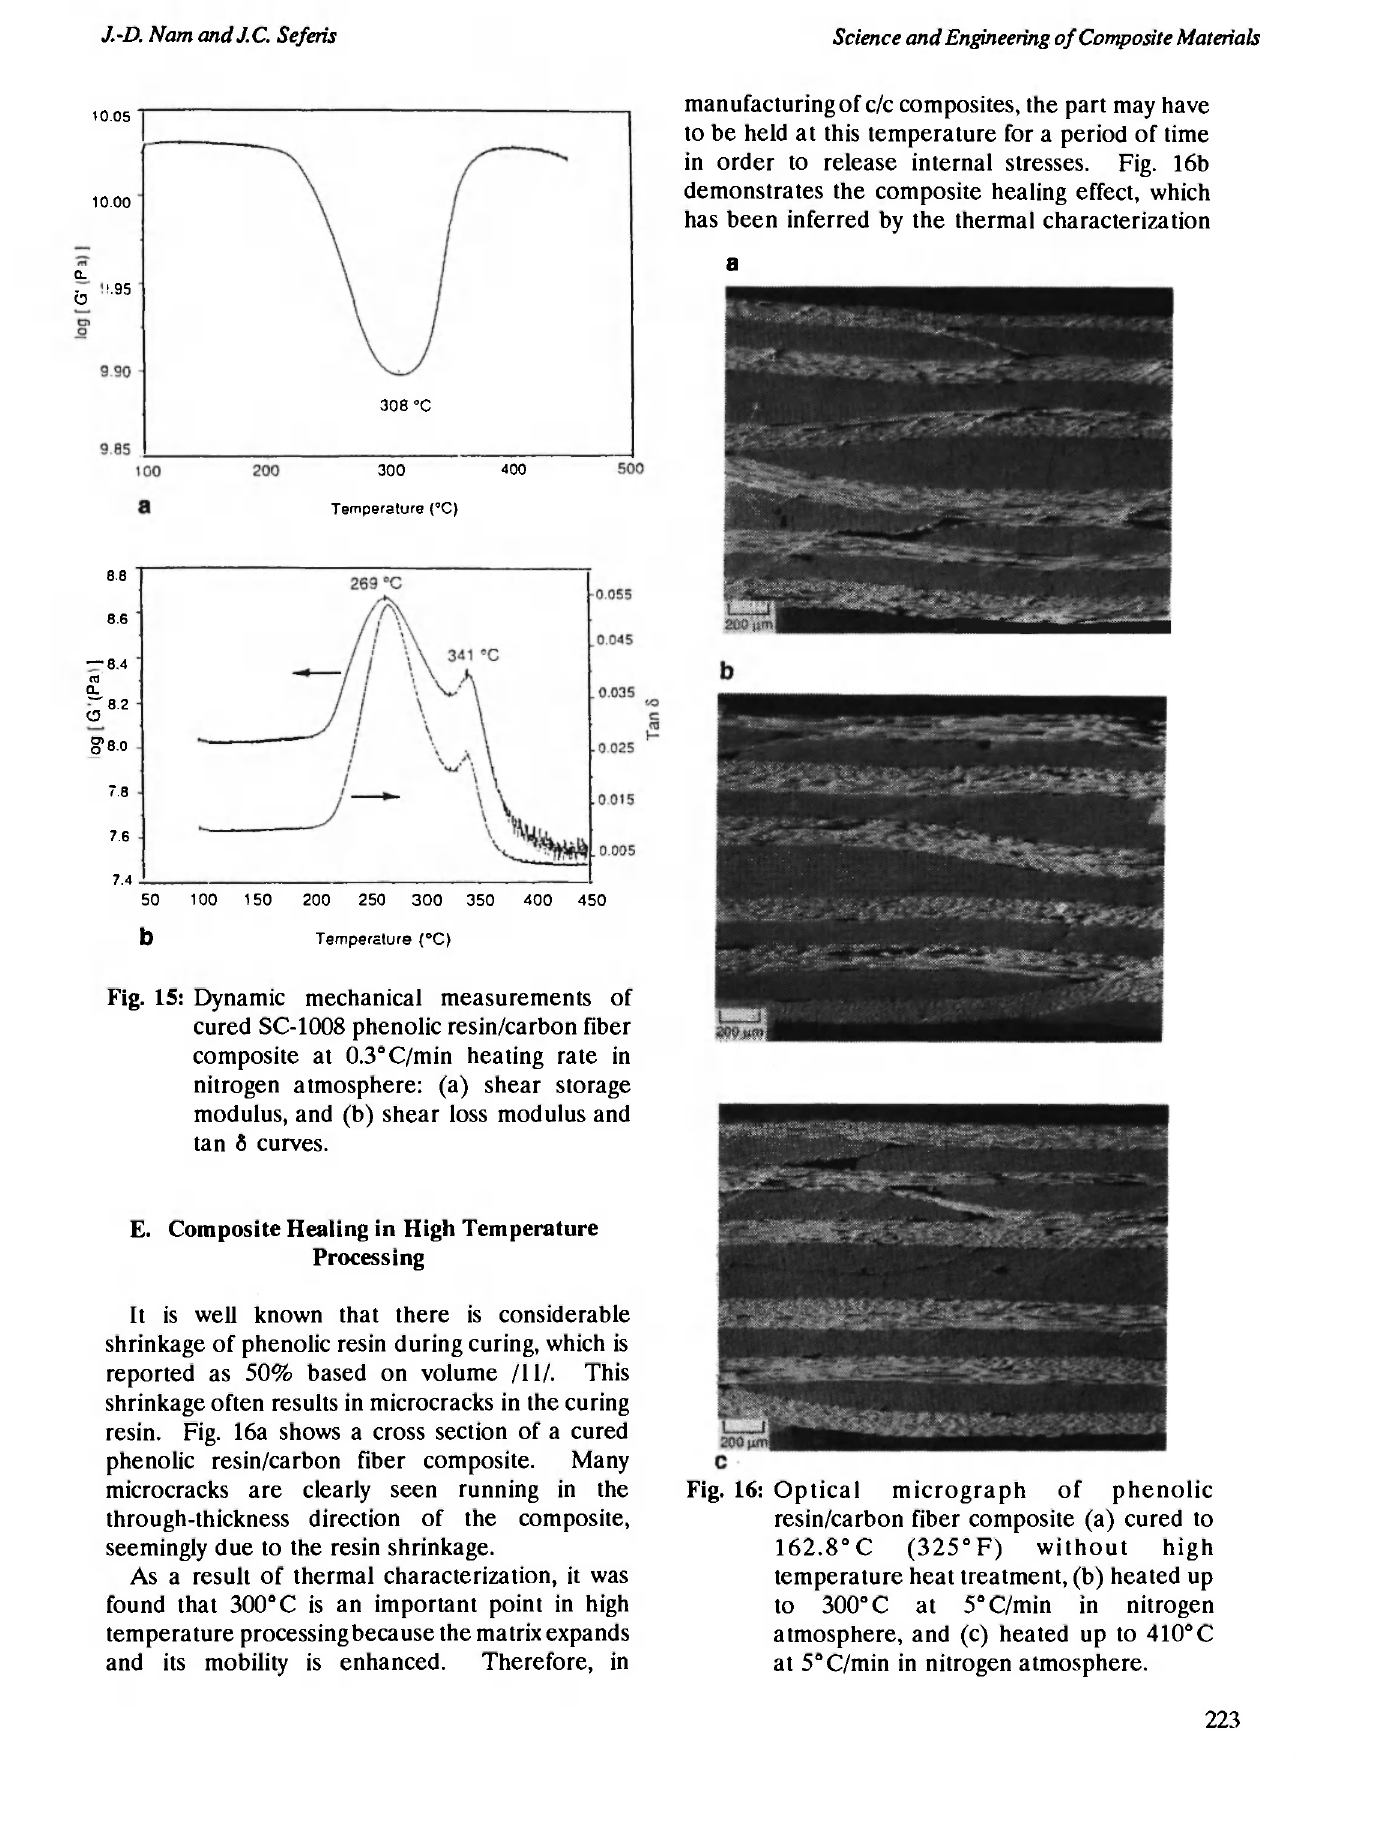
Fig. 15: Dynamic mechanical measurements of cured SC-1008 phenolic resin/carbon fiber composite at 0.3°C/min heating rate in nitrogen atmosphere: (a) shear storage modulus, and (b) shear loss modulus and tan δ